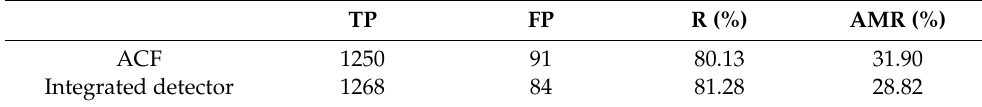
Table 10. Detection results for the Sunny Day sequence.